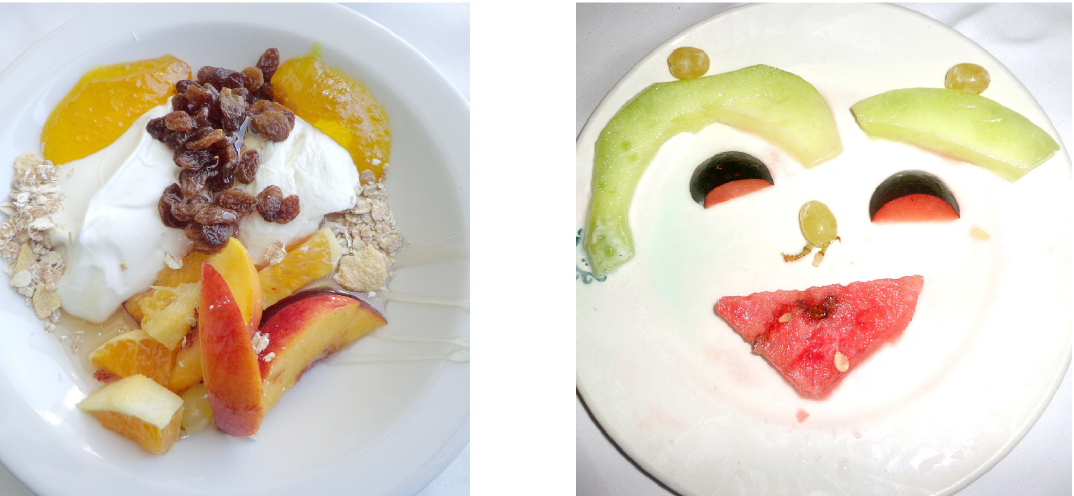
Fig 2. Examples of the Face-n-Food images. The least resembling face (left panel) and most resembling face (right panel) images from the Face-n-Food task.